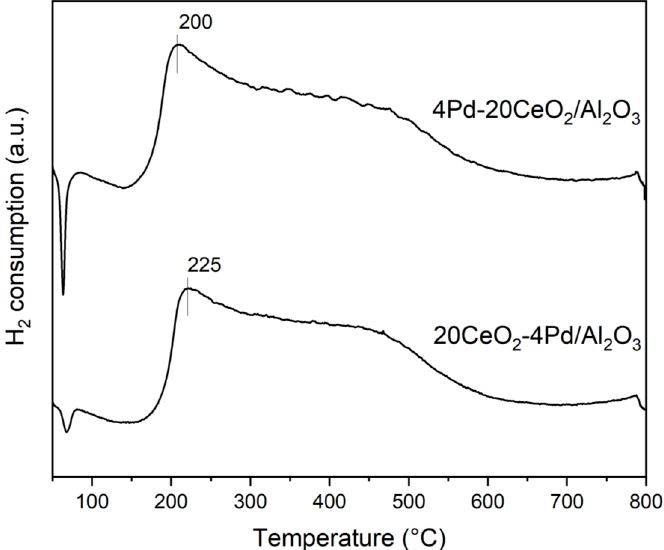
Figure 3. Hydrogen-TPR of the two catalysts.